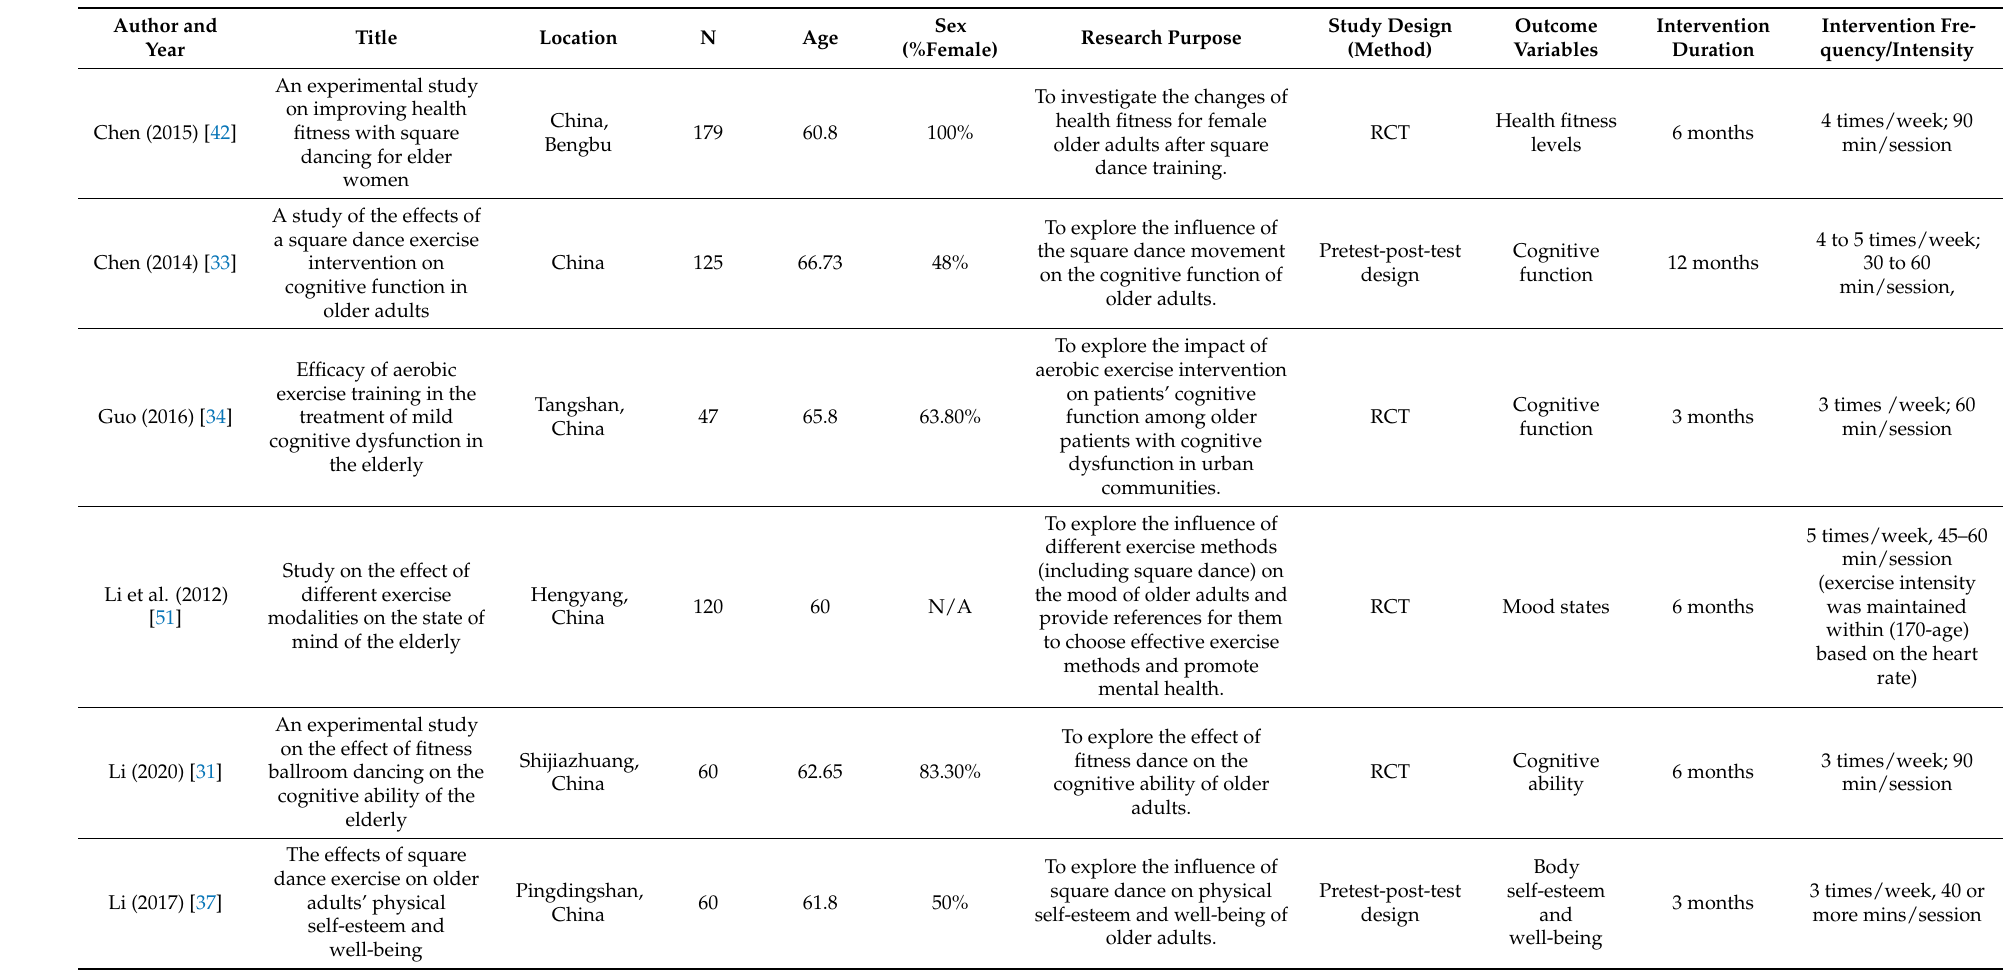
Table 1. Summary of the intervention